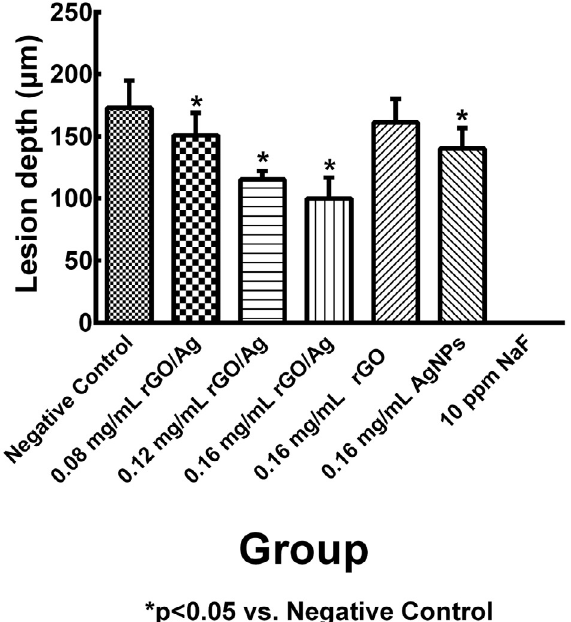
Figure 4- Graphical representation of the quantification results of the artificial enamel lesion depth of the teeth specimens in different treatment groups. (a) negative control; (b) 0.08 mg/mL rGO/Ag; (c) 0.12 mg/mL rGO/Ag; (d) 0.16 mg/mL rGO/Ag; (e) 0.16 mg/mL rGO; (f) 0.16 mg/mL AgNPs; (g) 10 ppm NaF; (h) native enamel. Lesion depth values are expressed as